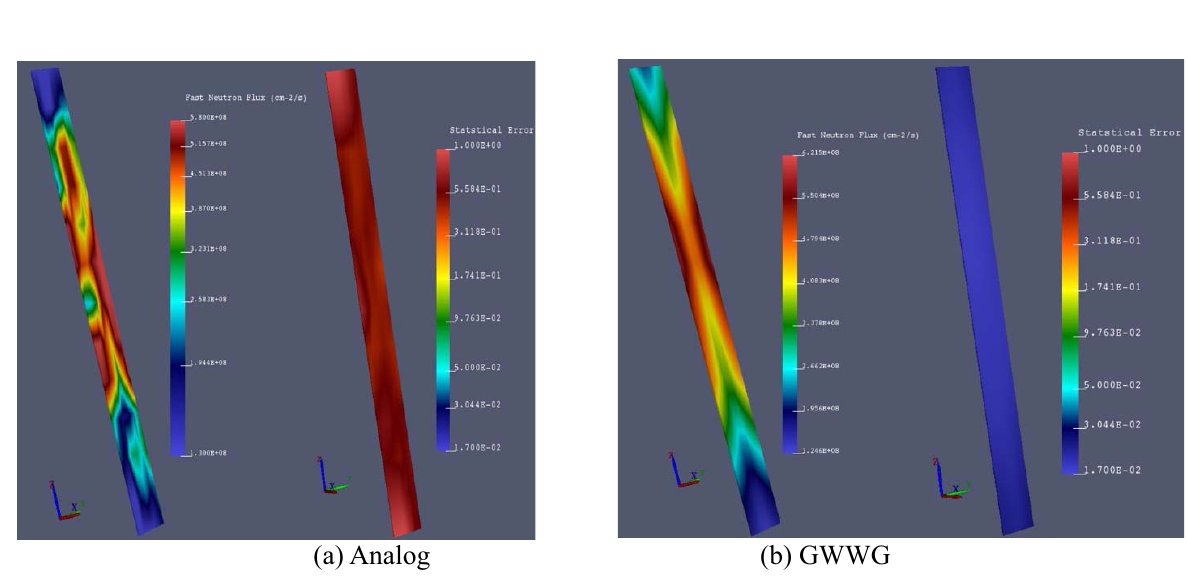
Figure 5. Map of fast neutron flux with statistical error on TF coil calculated by SuperMC Table III. FOMs of Analog and GWWG calculations performed by SuperMC Run Time (min) Error